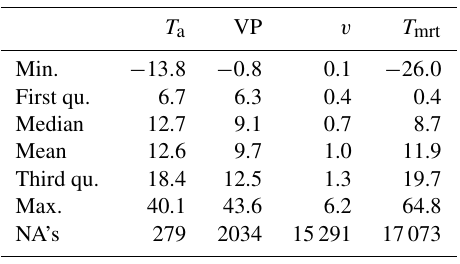
Table 5. Statistical overview over the meteorological data applied in the comparison of the thermal indices implemented in the biomete- orology module to the reference implementations provided by VDI guideline 3787, part II (VDI, 2008).